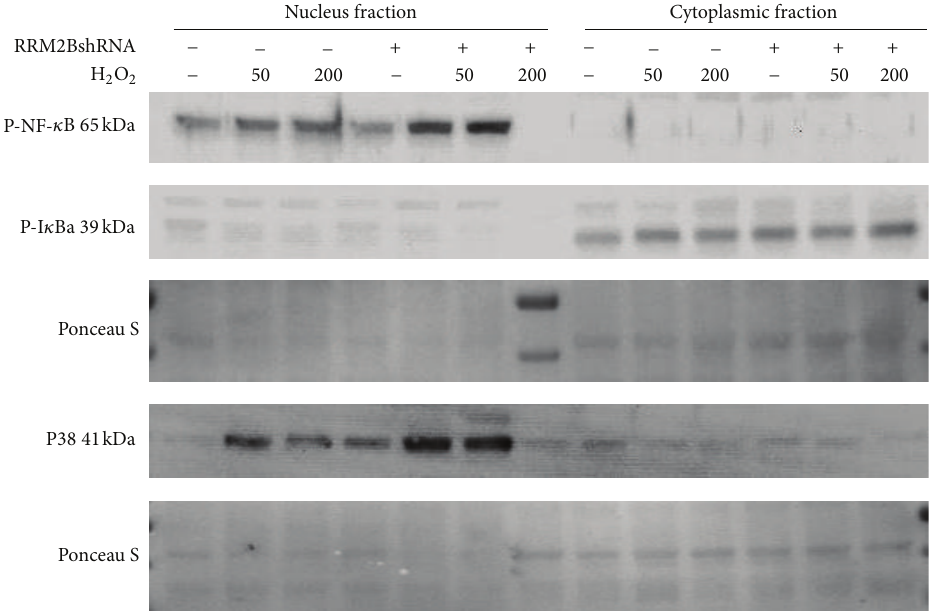
Figure 4: RRM2B regulates inflammatory signaling pathway under oxidative stress. (a) Stable cells were treated with 50 or 200 𝜇 M H 2 O 2 and harvested 2 hours later, and the lysates were separated into nuclear and cytoplasmic fractions for Western blot analysis. Antibodies against phosphorylated NF- 𝜅 B, phosphorylated I 𝜅 B, and phosphorylated p38 were applied, and GAPDH was used as loading control.